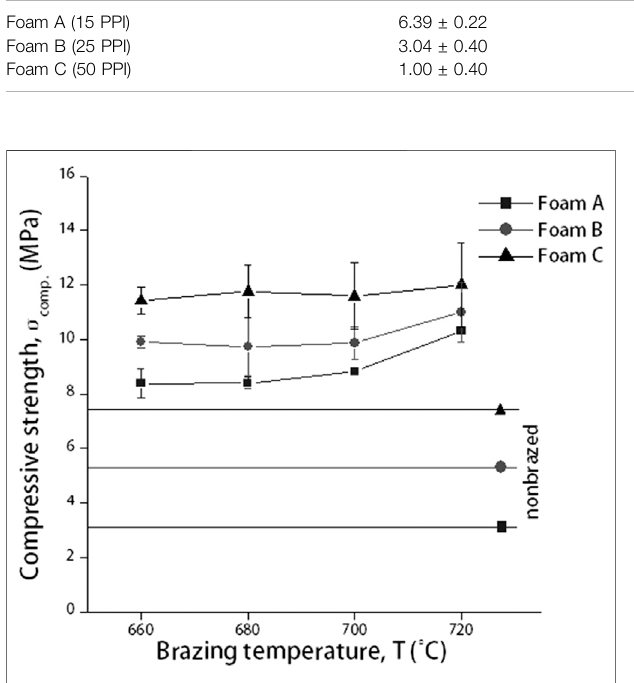
FIGURE 3 | Compressive stress – strain curve of brazed Cu/Cu foam/Cu at a brazing temperature of 720 ° C with different Cu foam pore densities and inset shows an elastic curve at a strain range of 0 – 0.14 ε